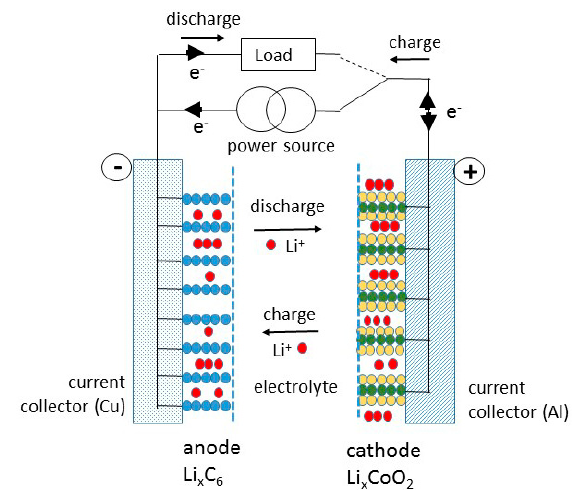
Figure 1. Schematic figure of a Li-ion battery. LiCoO 2 is used as a cathode and graphite as an anode.